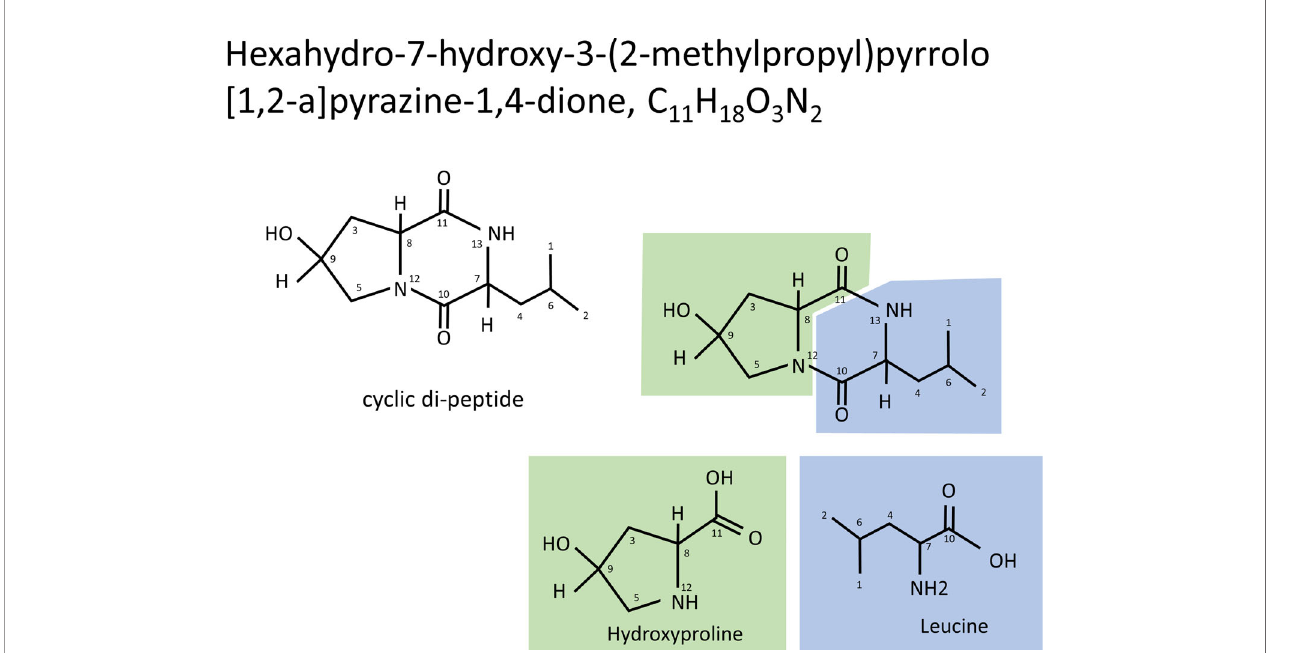
FIGURE 3 | Structure of cyclo (Hyp-Leu). From the result of NMR analysis, the molecule of C 11 H 18 O 3 N 2 was revealed to form a cyclic di-peptide of hydroxyproline and leucine.